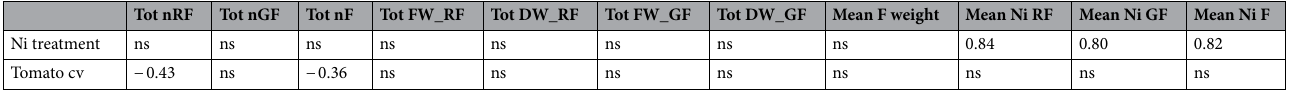
Table 2. Spearman’s rank order correlations. MD pairwise deleted Marked correlations are significant at P < 0.05. Tot. nRF total number of red fruits, Tot. nGF total number of green fruits, Tot. nF total number of fruits (red + green), Tot. FW_RF total fresh weight of red fruits, Tot. DW_RF total dry weight of red fruits, Tot. FW_GF total fresh weight of green fruits, Tot. DW_GF total dry weight of green fruits, Mean F weight mean